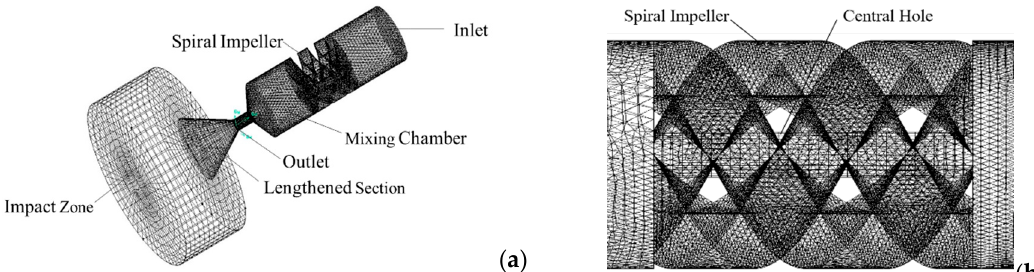
Figure 2. Three-dimensional geometric model for the simulation of the swirling-round SC-CO 2 jet flow field: ( a ) meshing of the flow region; ( b ) amplification of meshing at the rotating impeller and central